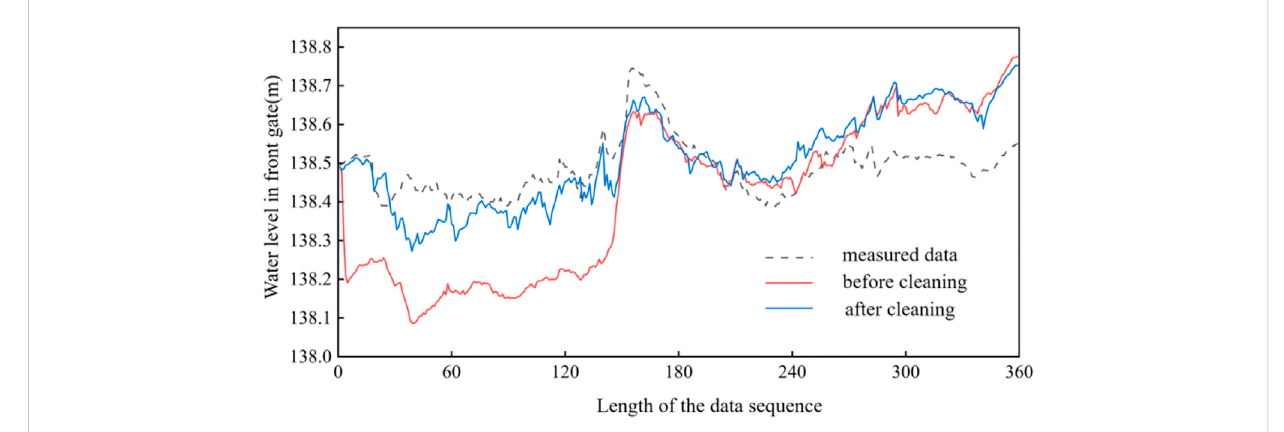
FIGURE 6 Comparison of hydrodynamic simulation results of Dongzhao River control